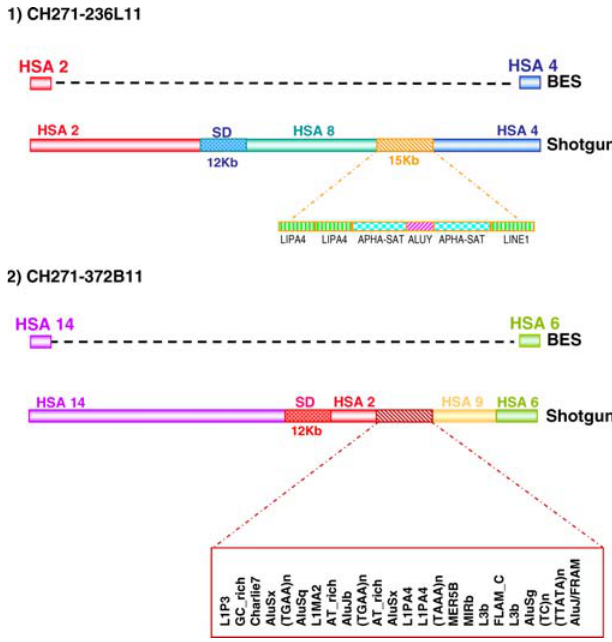
Figure 5. Analysis of Fully Sequenced Gibbon BAC Clones Two sequenced gibbon clones spanning rearrangement breakpoints revealed the presence of additional segments of synteny not observed by other methods. In both cases, the first break of synteny was found to contain SDs and the second to contain interspersed